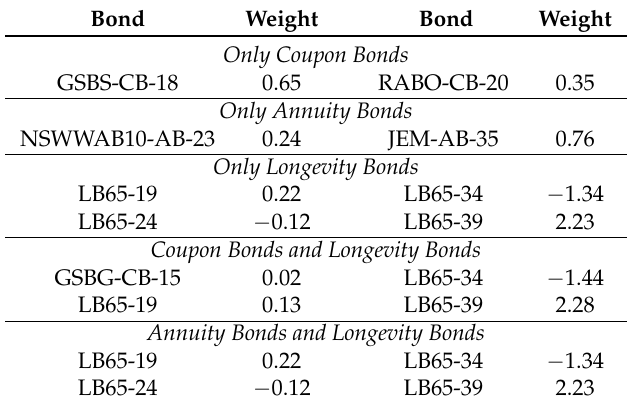
Table 13. Bond Portfolios to Delta-Gamma Hedge a Life Annuity Issued to 65 year